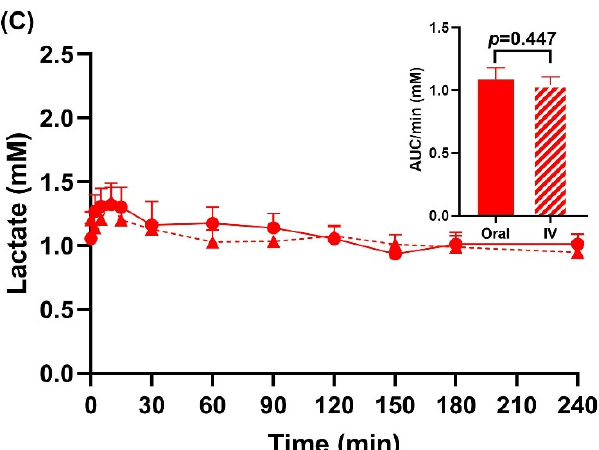
Figure 2. Total circulating concentrations of glycerol ( A ), glucose ( B ), and lactate ( C ) for oral (solid) and intravenous (dashed, IV) 13 C 3 -glycerol administration. Inset graphs have the area under the curve (AUC) data. * p < 0.05 via paired t-test or Wilcoxon sign-rank test between oral and intravenous administration. n = 8.